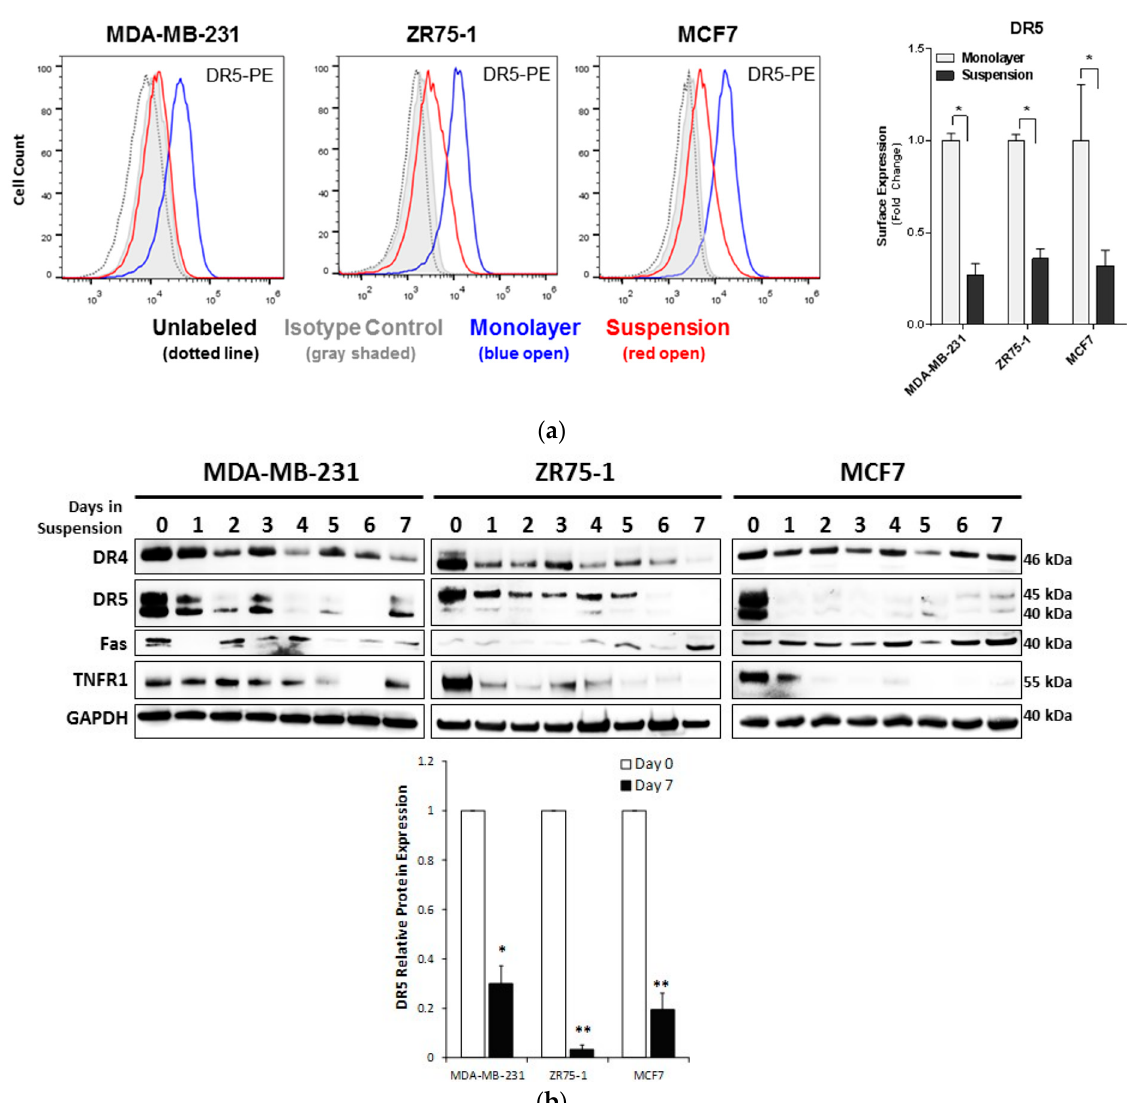
Figure 2. Surface expression of death receptors are decreased in breast cancer cells under suspension conditions. ( a ) Surface expression of the DR5 was analyzed by flow cytometry on breast cancer cells (BCCs) cultured in monolayer and suspension, for seven days. Surface expression was analyzed using Relative Median Fluorescence Intensity (RMFI) of the DR5, determined by the Median Fluorescence Intensity (MFI) obtained for the suspension-cultured cells, normalized to the corresponding MFI obtained for monolayer cells (Day 0) (mean ± SEM; * p < 0.05; n = 3). The reduction in surface level protein is indicated with a median shift of the suspension cultured cells (red line), from the monolayer (blue line) towards the isotype (gray shading), and the unlabeled control (dotted line). ( b ) Western blot analysis of the BCC lines cultured in the suspension condition and collected each day. Cell lysates were analyzed for DR4, DR5, Fas, and TNFR1 with GAPDH as a loading control (quantification of each blot can be found in Figure S3). Relative protein expression of the DR5 (relative densitometric analysis) to monolayer (day 0). (* p < 0.05, ** p < 0.01 to monolayer; n =